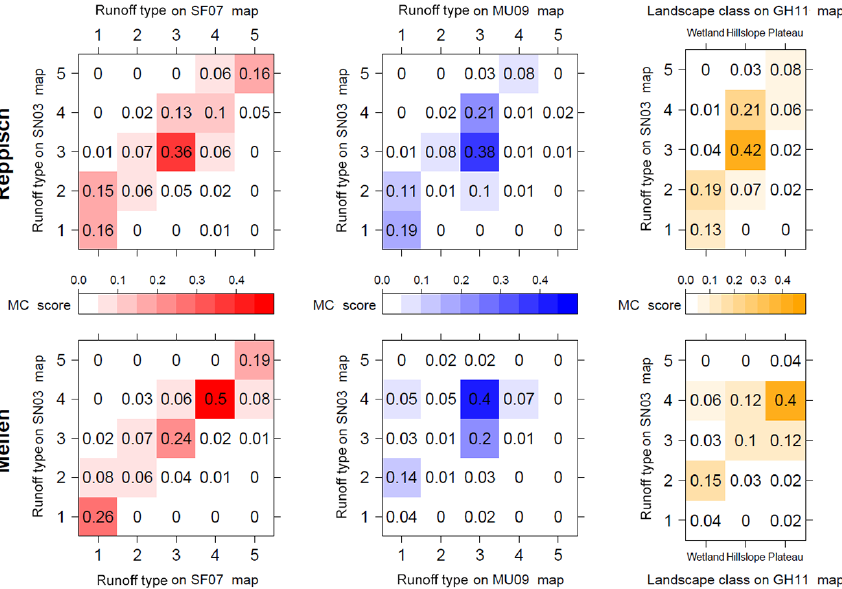
Figure 10. MC scores related to each RT obtained by comparing the maps derived with automatic mapping approaches SN07, MU09, and GH11 with the reference (SN03) maps for the two study sites.